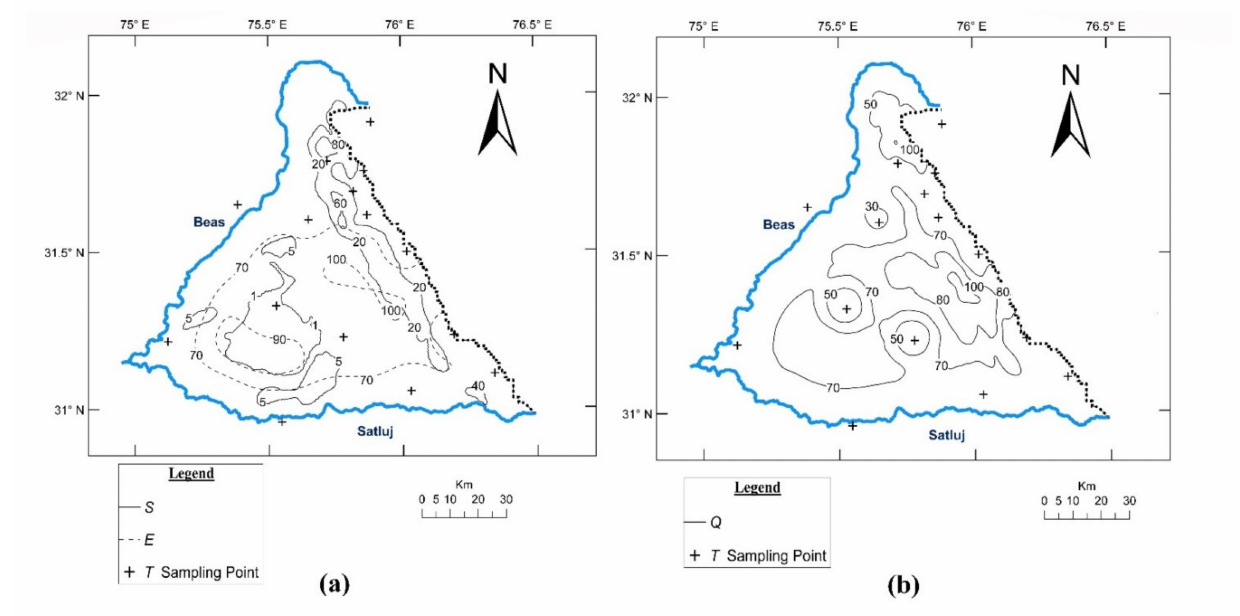
Figure 2. ( a ) Fields of S and E. ( b ) Field of Q